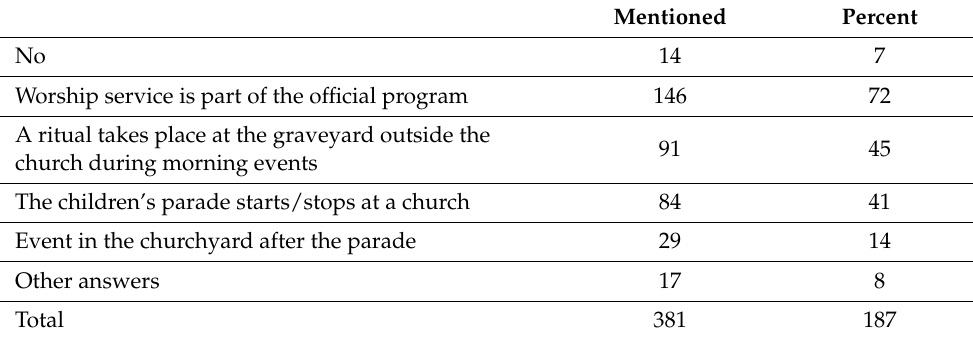
Table 2. Do parts of the public celebrations in your municipality take place in spaces near the Church of Norway? * (N =